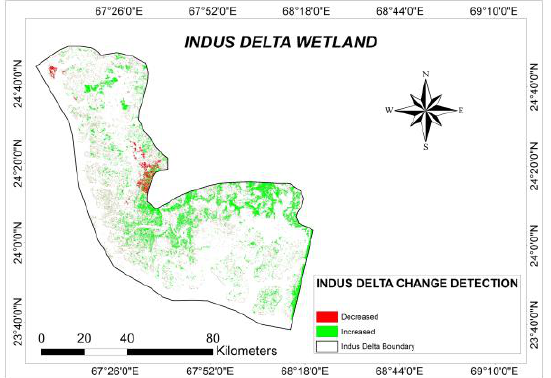
Figure 7: Landcover map of Indus Delta 2016 The most significant difference is seen in built-up area which is depicting global urbanization trend.